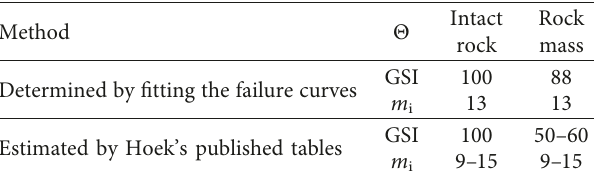
Table 2: Hoek–Brown strength parameters. Table 3: Comparison between the fitting method and the published estimating